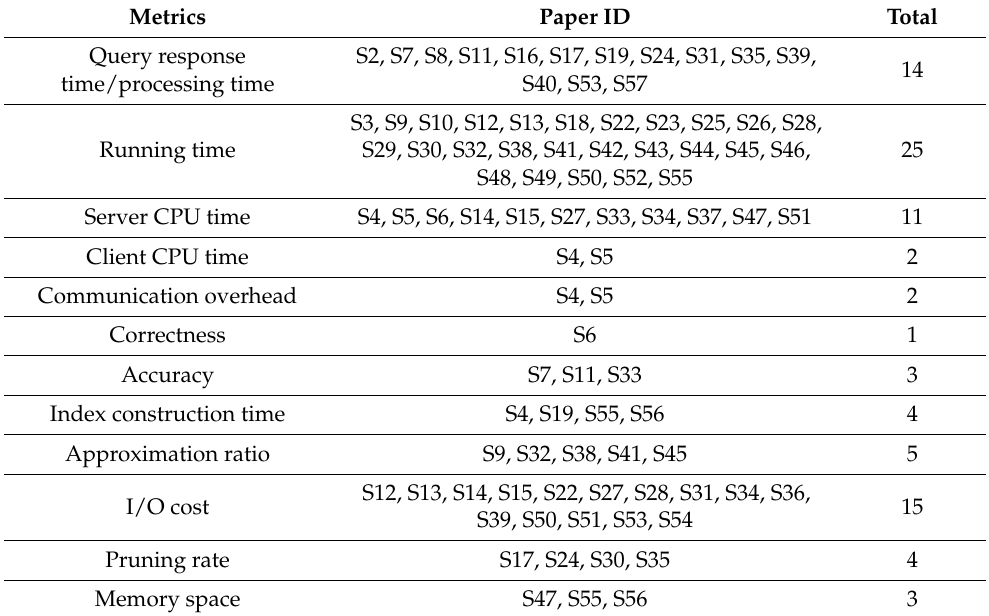
Table 18. Metrics used by the selected